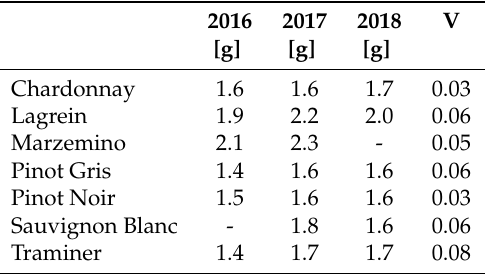
Table 2. Average single berry weight in grams for different grape varieties in Trentino (Italy) for the years 2016, 2017, 2018, with the overall relative deviation